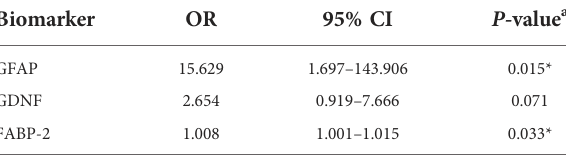
TABLE 4 Logistic-regression analysis of biomarker values at birth on the risk of NEC.